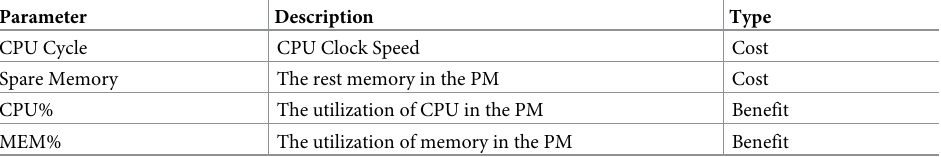
Table 2. The main parameters of the scheduling